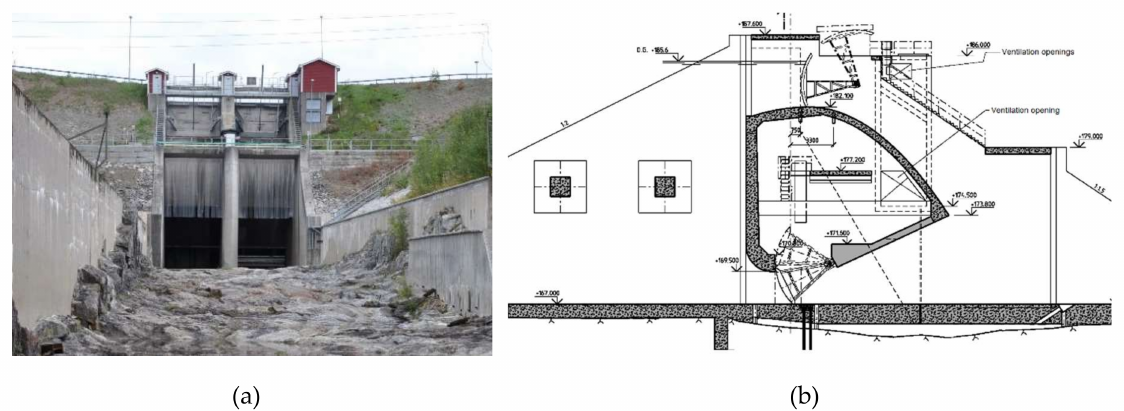
Figure 7. Torpshammar’s gated overflow openings and bottom outlets: ( a ) Looking upstream from the discharge channel; ( b ) Longitudinal